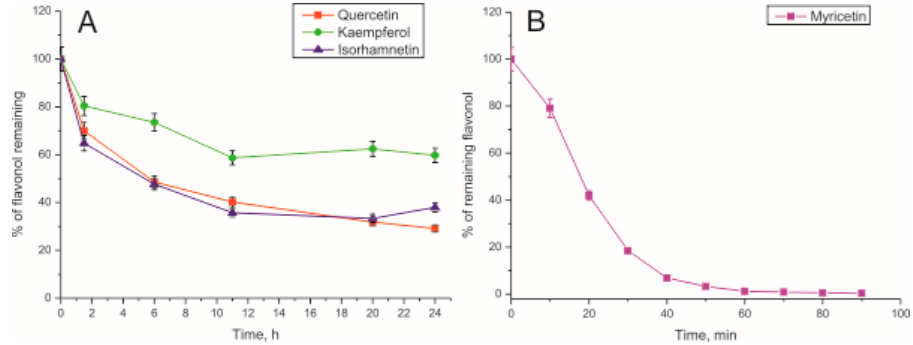
Figure 3. The loss of the starting amount in saliva solution as percent of remaining: ( A ) kaempferol, quercetin, and isorhamnetin; and ( B ) myricetin.